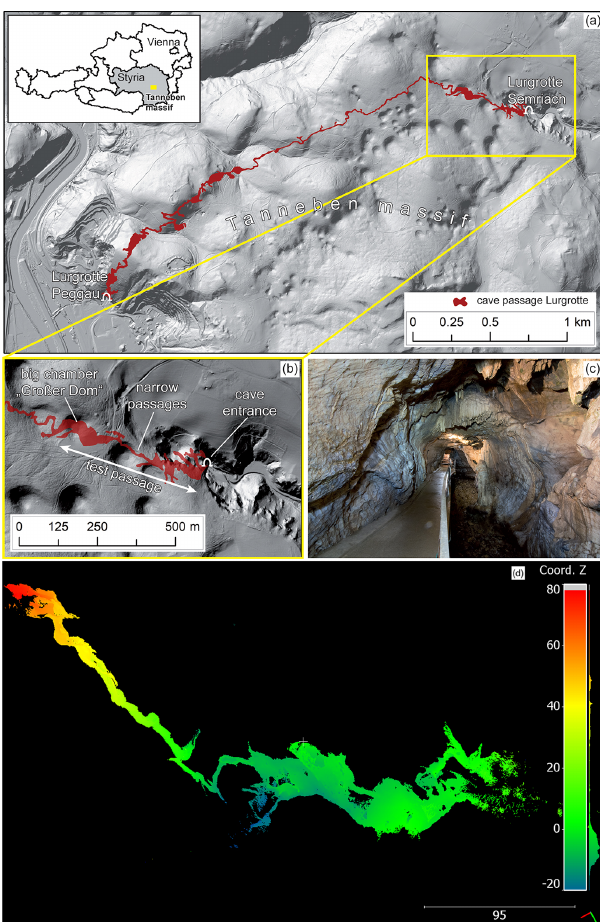
Figure 5. Study area Lurgrotte Semriach. (a) Hillshade visualiza- tion (1m × 1m raster resolution) and cave map; (b) detailed view of the test passage in which the OS1-64 surveys were carried out in- cluding the Great Dome (Großer Dom); (c) a narrow passage with paved footpath within the cave segment open for visitors (image by Christian Bauer). Data: cave map: Bock and Dolischka (1953); ALS-data: CC-BY-4.0: Land Steiermark – https://data.steiermark. at/ (last access: 30 July 2022). (d) Measurement (2), starting at cave entrance, turning point right before the Great Dome, and end at cave entrance; point cloud colored by z coordinate in meters, visualized with